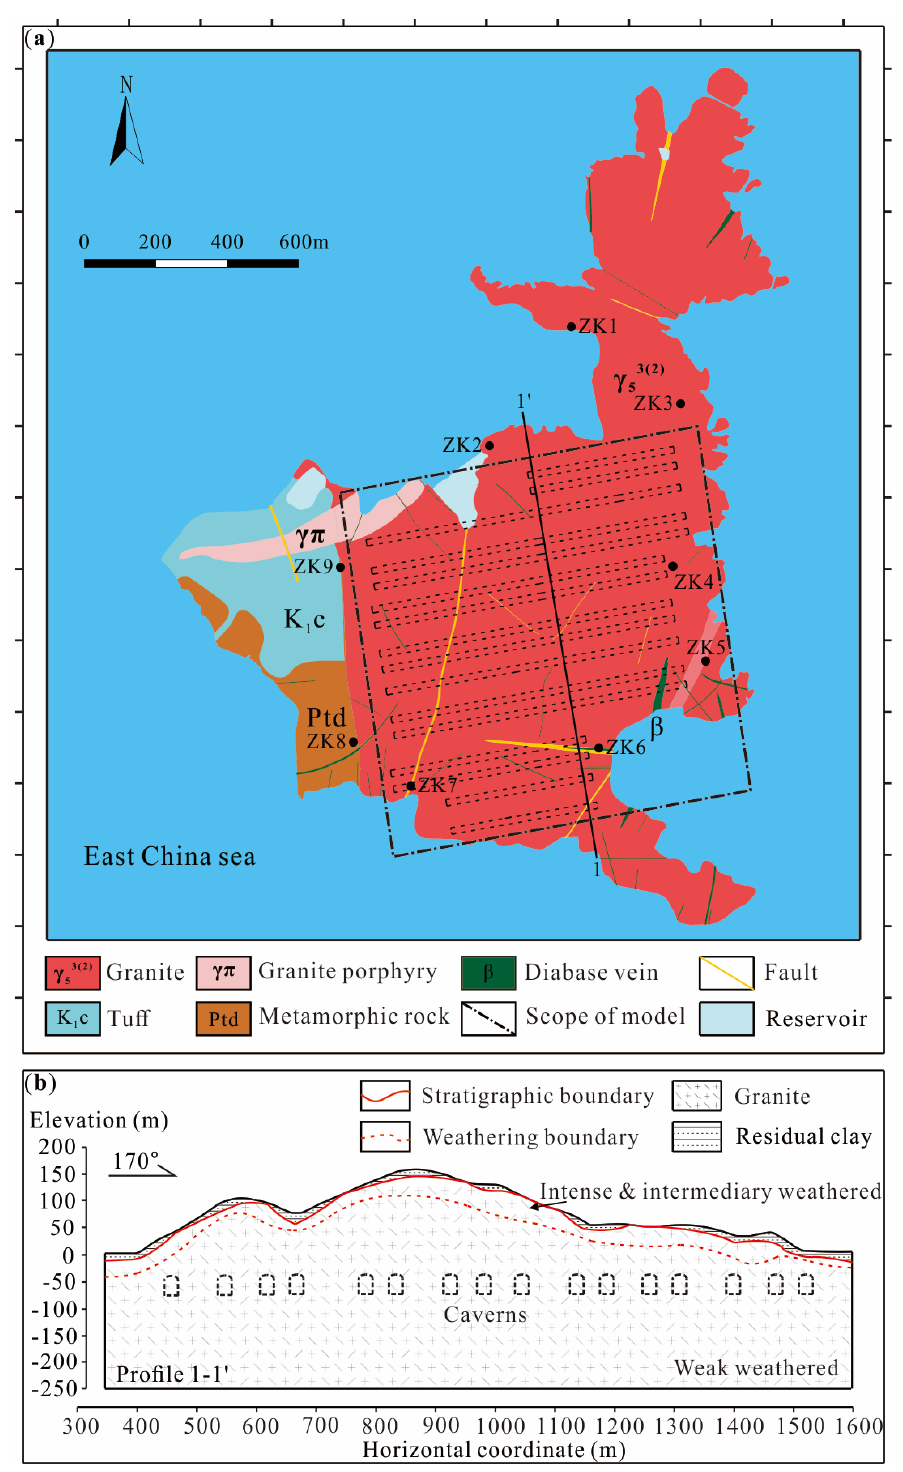
Figure 3. Geological map of the study area: ( a ) plane map, ZK1-ZK9 are the number of groundwater table monitoring boreholes; ( b ) profile map.